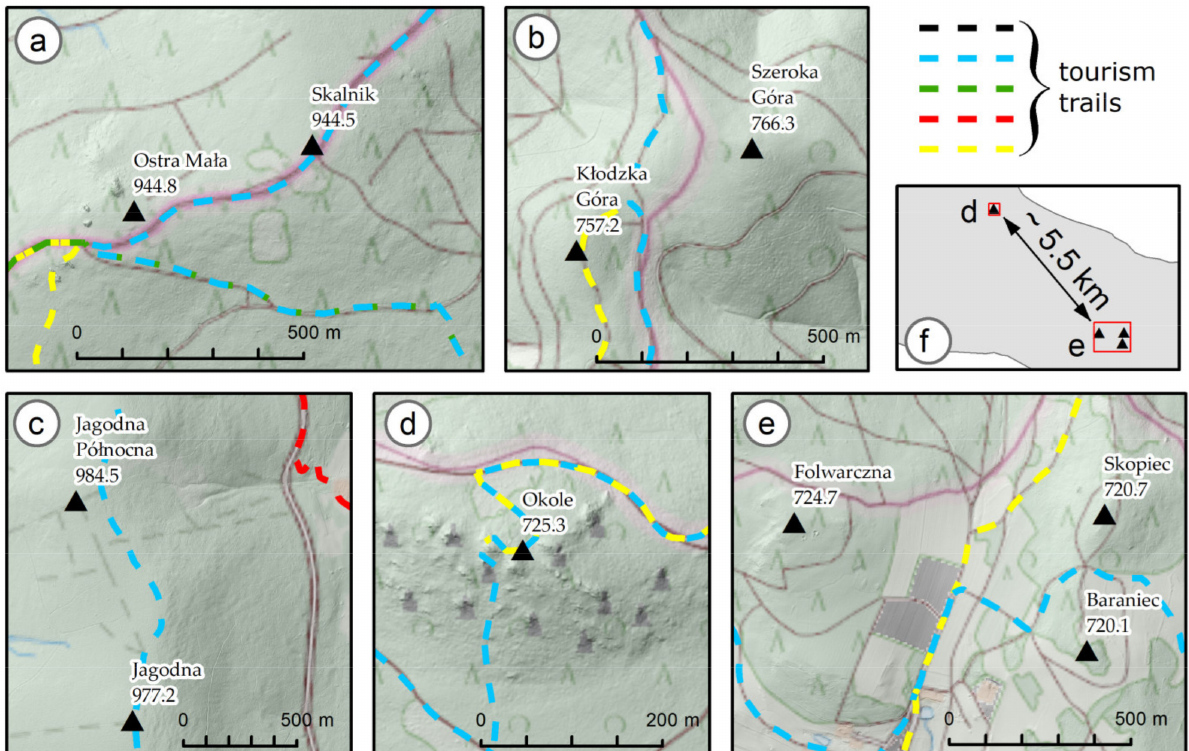
Figure 9. Tourism trails and infrastructure in the monitored areas. ( a ) The Rudawy Janowickie Mountains, ( b ) the Bardzkie Mountains, ( c ) the Bystrzyckie Mountains, ( d , e ) the Kaczawskie Mountains, ( f ) the location of the four sum- mits in the Kaczawskie Mountains that were measured. Sources: WMTS (Web Map Tile Service)—Visualization of the BDOT10k Database for the area of Poland